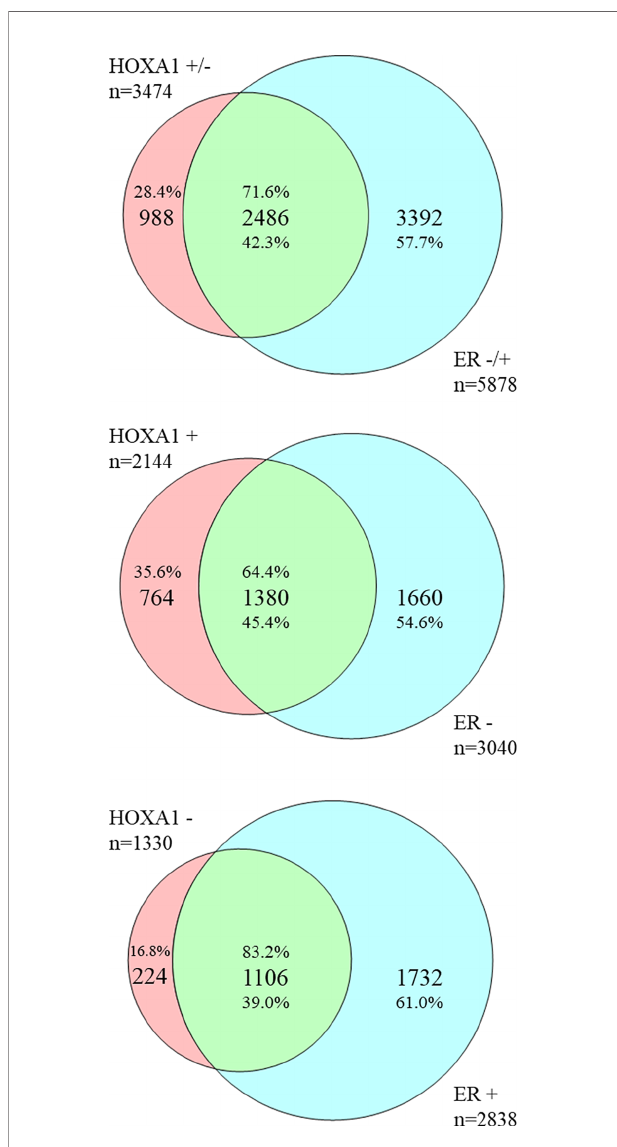
FIGURE 2 | HOXA1- and ER status-correlating genes in breast cancer correlate inversely. Overlap between HOXA1- and ER status-correlating genes extracted from public genome-wide mRNA expression breast cancer datasets. Venn diagrams represent the large overlap between genes whose mRNA expression correlates with that of HOXA1 , and with ER status. Top diagram: Of 3474 genes correlated with HOXA1 expression, the majority, 2486 genes (71.6%), show an inverse correlation with ER status. This is 42.3% of genes correlated with ER status (5878 genes total). Middle diagram: Of 2144 genes positively correlated with HOXA1 expression, a smaller majority, 1380 genes (64.4%), show an inverse correlation with negative ER status. This is 45.4% of genes oppositely correlated with ER status (3040 genes total). Bottom diagram: Of 1330 genes correlated with HOXA1 expression, a large majority, 1106 genes (83.2%), show an inverse correlation with positive ER status. This is 39.0% of genes correlated with positive ER status (2838 genes total). The results are in support of an opposite correlation between HOXA1 mRNA expression and ER status in breast cancer, and suggest that especially genes negatively associated with HOXA1 mRNA, e.g. genes potentially downregulated by HOXA1, are involved in ER status in breast